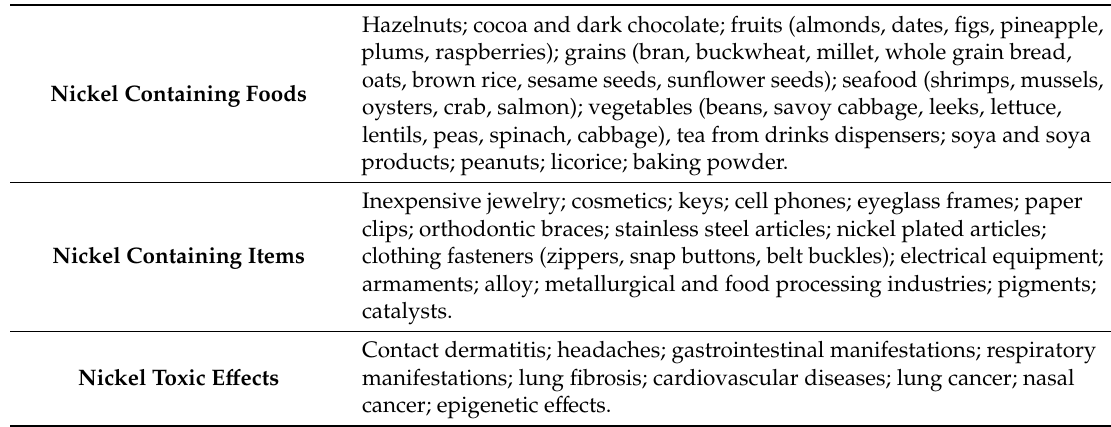
Table 1. Nickel-containing foods and items and nickel toxic e ff